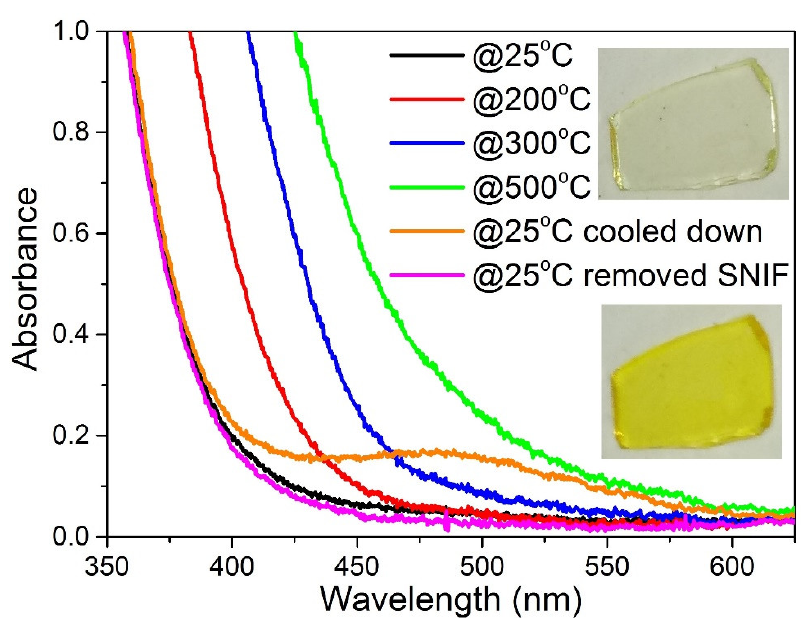
Figure 12. In situ absorbance spectra measured at different temperatures of PTR-Br glass sample ion-exchanged for 15 min and heat-treated at 500 °С for 9 h. Inset: photos of the sample at room temperature ( top image ) and after pulling it out from a muffle furnace heated to 500 °С ( bottom image ).